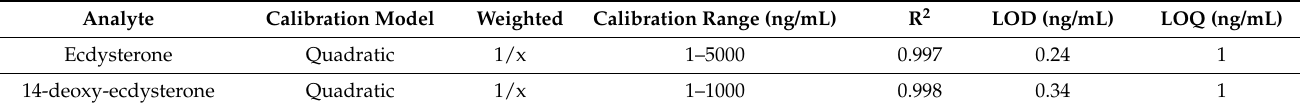
Table 1. Calibration model LOD and LOQ.